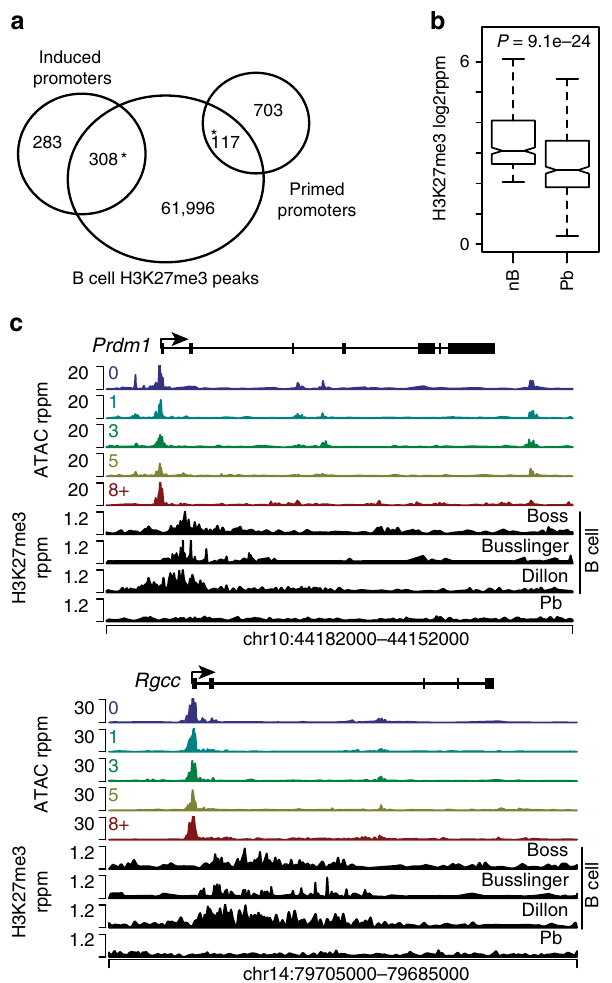
Fig. 6 H3K27me3 marks a subset of primed-accessible promoters. a Venn diagram displaying the overlap of regions enriched for H3K27me3 in B cells with primed and induced accessible promoters. A signi fi cant overlap with a * P -value < 1e − 5 as determined by Fisher ’ s exact test. b Box plot showing a comparison of H3K27me3 enrichment at primed-accessible promoters in B cells versus splenic plasmablasts. Boxplot center line indicates data median, lower and upper bounds of boxes the 1st and 3rd quartile ranges, and whiskers the upper and lower ranges of the data. Signi fi cance was determined by a two-tailed Student ’ s T -test. c Promoter accessibility across all divisions and H3K27me3 enrichment in B cells and plasmablasts are displayed for two example loci. H3K27me3 ChIP-seq data was an average of two biological replicates from both B cells and